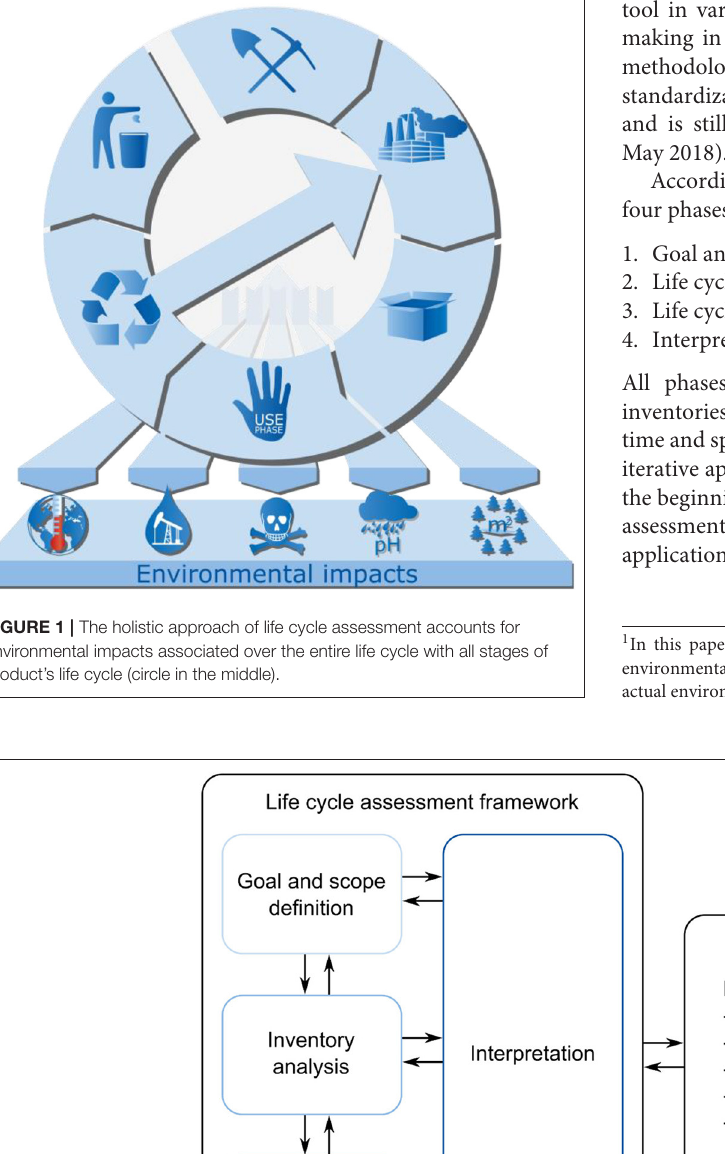
Frontiers in Energy Research |